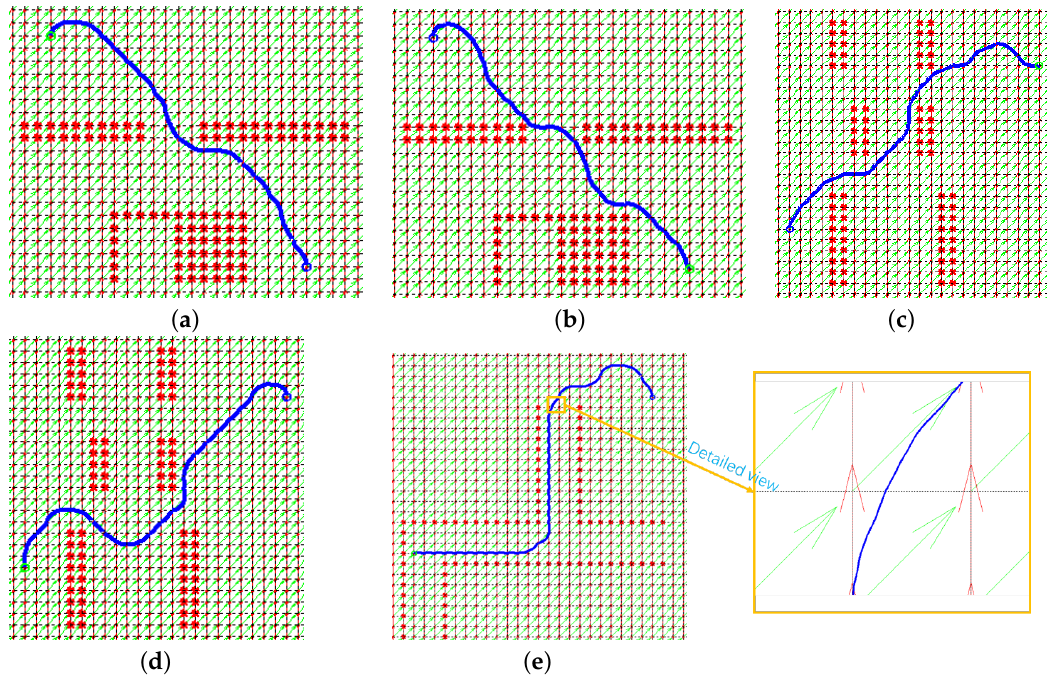
Figure 12. Motion planning for a USV in obstacle environments at different starting and ending points, considering wind and current disturbances. ( a ) Motion planning for a USV at the starting point (25, 6) and the ending point (5, 24). ( b ) Motion planning for a USV at the starting point (5, 24) and the ending point (25, 6). ( c ) Motion planning for a USV at the starting point (2, 9) and the ending point (25, 24). ( d ) Motion planning for a USV at the starting point (25, 24) and the ending point (2, 9). ( e ) Motion planning for a USV at the starting point (25, 24) and the ending point (2,